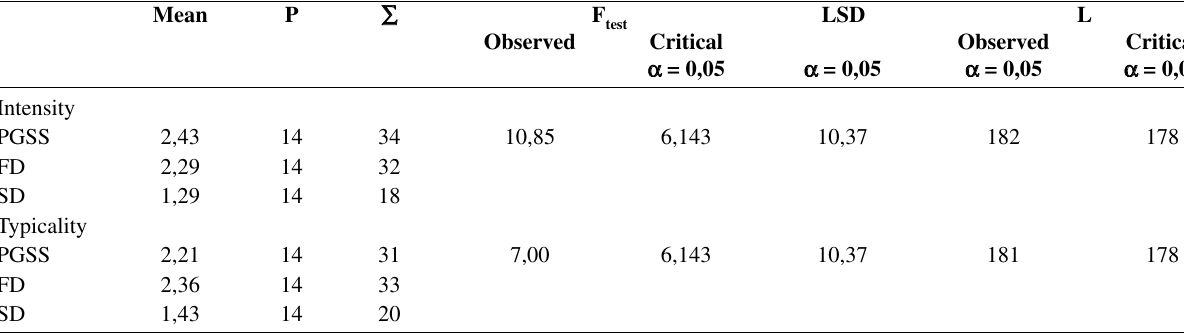
Table 12. – Sensory evaluation for banana fruit